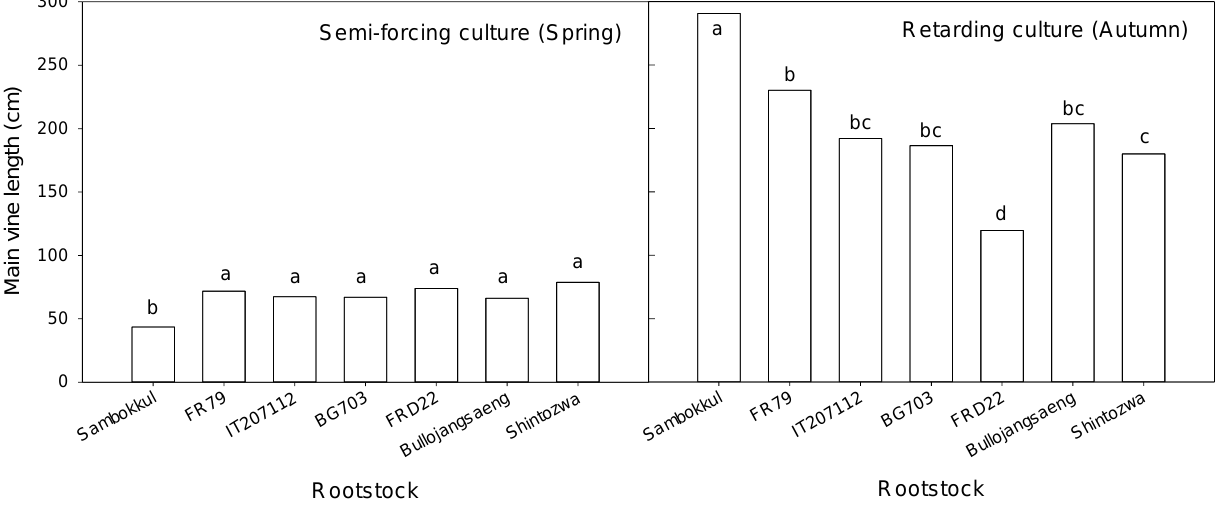
Figure 5. Main vine length influenced by bottle gourd rootstocks at 27 days after transplanting in semi-forcing and retarding culture. Different letters indicated a significant difference within the column at the p ≤ 0.05, according to Duncan’s multiple range test.